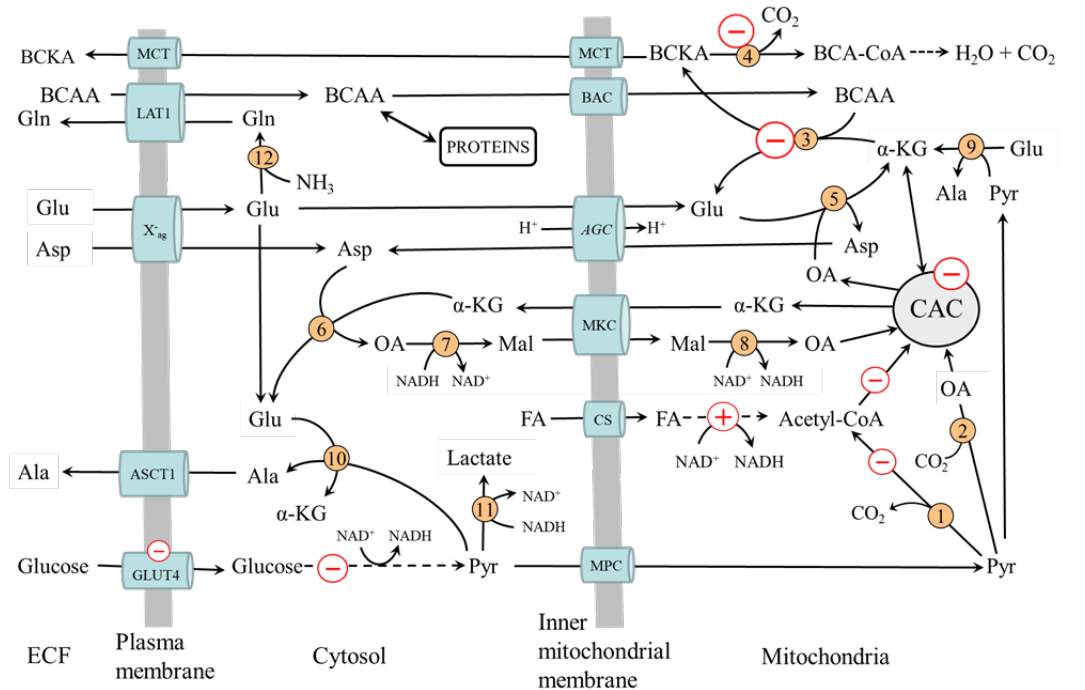
Figure 4. Muscle BCAA metabolism in diabetes. The pluses and minuses indicate the main changes associated with decreased glycolysis and preferential fatty acid oxidation resulting in impaired BCAA catabolism. 1, pyruvate dehydrogenase; 2, pyruvate carboxylase; 3, BCAA aminotransferase; 4, BCKA dehydrogenase; 5, AST mitochondrial; 6, AST cytosolic; 7, cytosolic malate dehydrogenase; 8, mitochondrial malate dehydrogenase 9, ALT mitochondrial; 10, ALT cytosolic; 11, lactate dehydrogenase; 12, glutamine synthetase. AGC, aspartate-glutamate carrier; ASCT1, alanine, serine, cysteine, and threonine carrier 1 (SLC1A4); BCAA, branched-chain amino acids; BAC, branched-chain amino acid carrier (SLC25A44); BCA-CoA, branched-chain acyl-CoA; BCKA, branched-chain keto acids; CAC, citric acid cycle; CS carnitine system; ECF, extracellular fluid; LAT1 (large neutral amino acid transporter 1); Mal, malate; MCT, monocarboxylate transporter; MKC, malate-ketoglutarate carrier; OA, oxaloacetate; MPC, mitochondrial pyruvate carrier; X -ag , a transporter for aspartate and glutamate (SLC1 family).